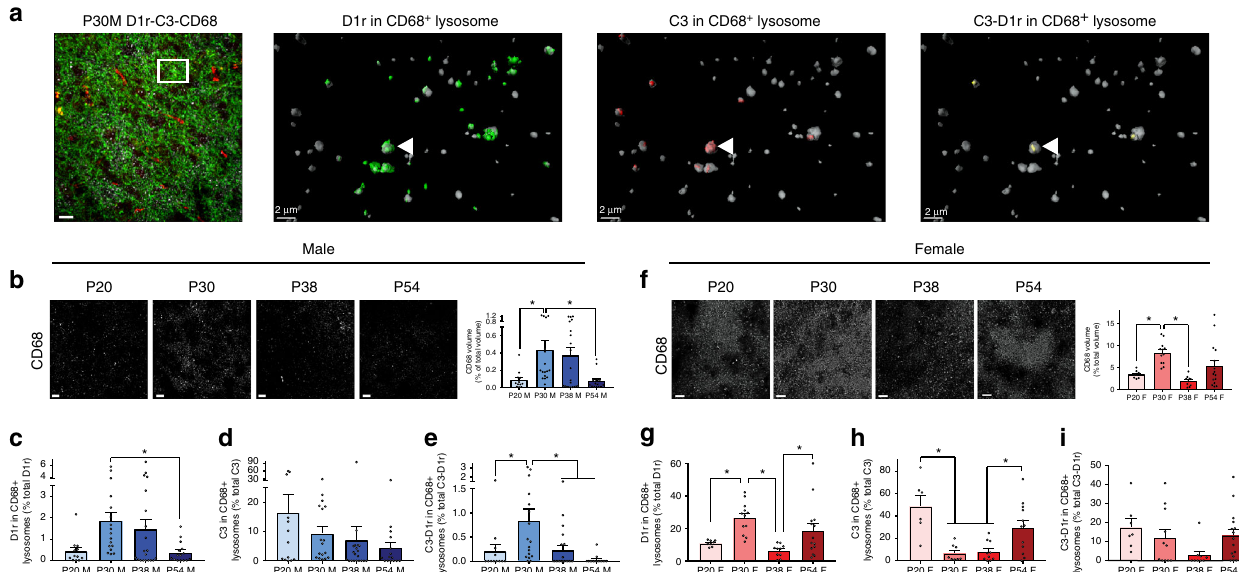
Statistical details for every analysis in Fig. 1